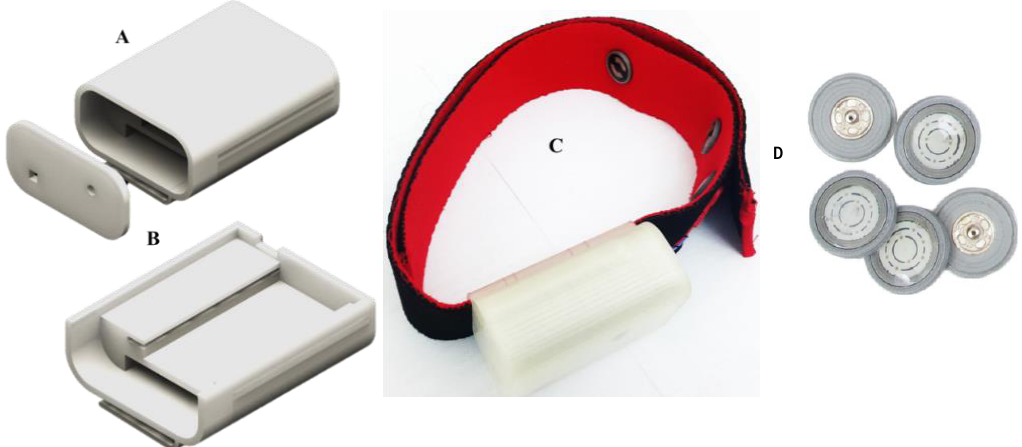
Figure 3: Exterior (A), interior view (B) of the 3D model of the ECG amplifier, and (C) ECG Figure 3 . Exterior ( A ) and interior view ( B ) of the three-dimensional (3D) model of the Figure amplifier with the chest-belt and (D) dry electrodes. electrocardiograms (ECG) amplifier and ( C ) the ECG amplifier with the chest best and ( D ) dry electrodes.